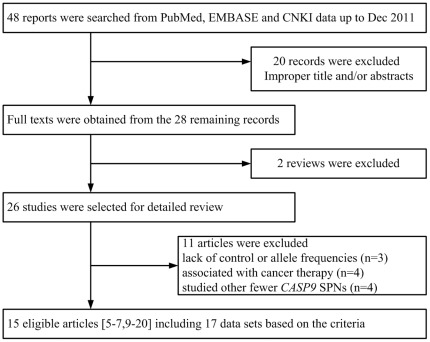
Flow diagram of study identification.